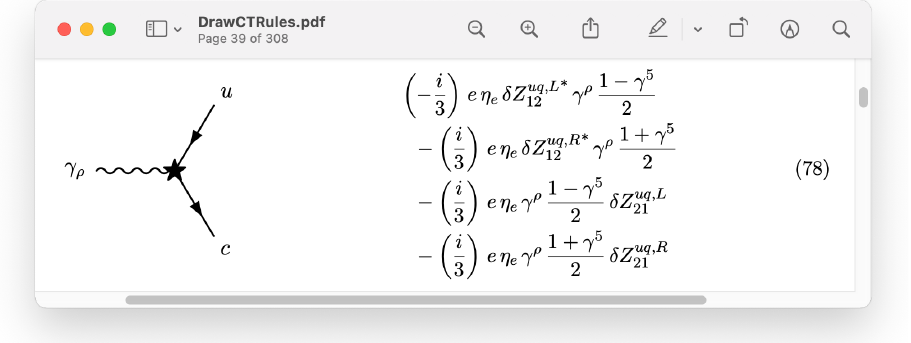
Figure 8 . Excerpt from the DrawCTRules.pdf file, containing the Feynman diagrams and rules for the counterterm interactions ( η e is one of the η ’s from ref.